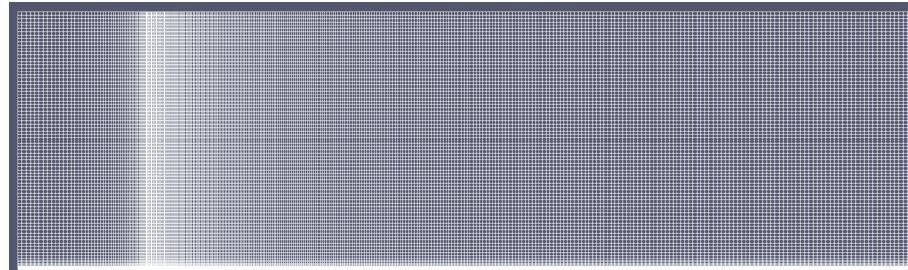
Figure 6. Grid of the flat plate.